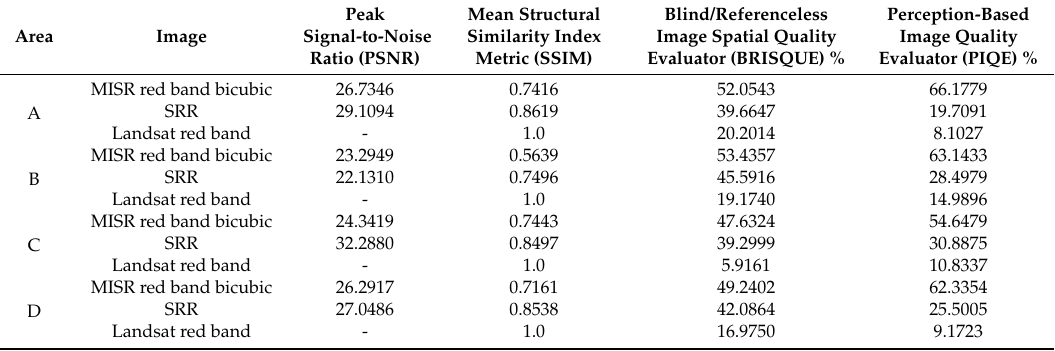
Table 1. Statistics of the image quality metrics for the bicubic interpolated MISR red band input reference image, SRR results, and the Landsat 7 red band validation reference image for the 4 areas in the first testing